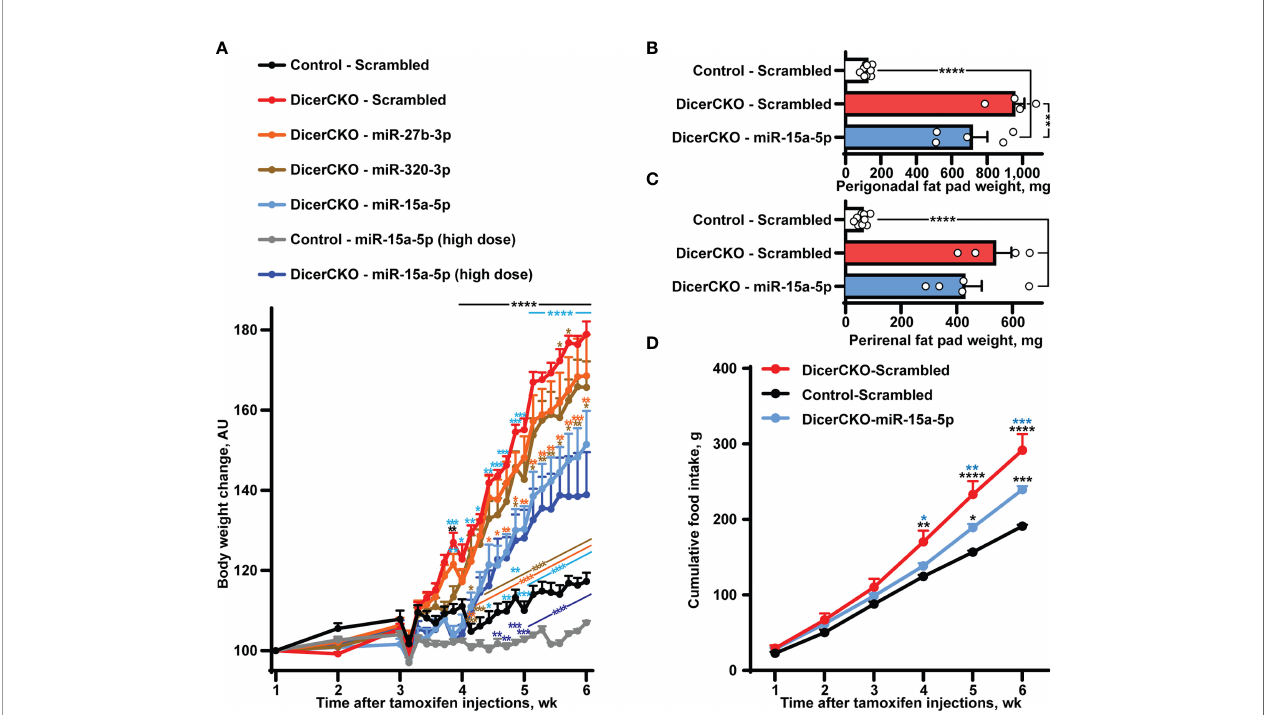
FIGURE 2 | Stabilized miR-15a-5p mimic attenuates hyperphagia and obesity in DicerCKO mice. (A) Body weight dynamics in DicerCKO females injected by miR-27b-3p, miR-320-3p, miR-15a-5p LNA-stabilized mimics or scrambled nucleotides and control mice injected to the arcuate hypothalamic nucleus (ARH) by scrambled oligonucleotides (n = 5, 5, 5, 4, 9, respectively). A separate experiment was done to deliver high dose of miR-15a-5p mimics to ARH of DicerCKO or controls mice (n = 5). (B – D) Perigonadal (B) , perirenal (C) fat pad and food intake (D) analyses in Control - Scrambled, DicerCKO - Scrambled and DicerCKO - miR-15a-5p mice (n = 9, 4, 5, respectively). Error bars represent SEM. * p < 0.05; ** p < 0.01; *** p < 0.001; **** p < 0.0001 vs. groups indicated by respective colors, as assessed by 2-way ( A , F (23, 529) = 466.9, F (23, 529) = 60.48 and F (92, 529) = 29.66 for time, experimental group and interaction factors; D , F (5, 55) = 912.4, F (11, 55) = 18.44 and F (10, 55) = 15.71 for time, experimental group and interaction factors) or 1-way (B, C, F (2, 15) = 46.84 and 80.56, respectively) ANOVA followed by Holm-S ̌ ı ́ da ́ k pairwise comparison